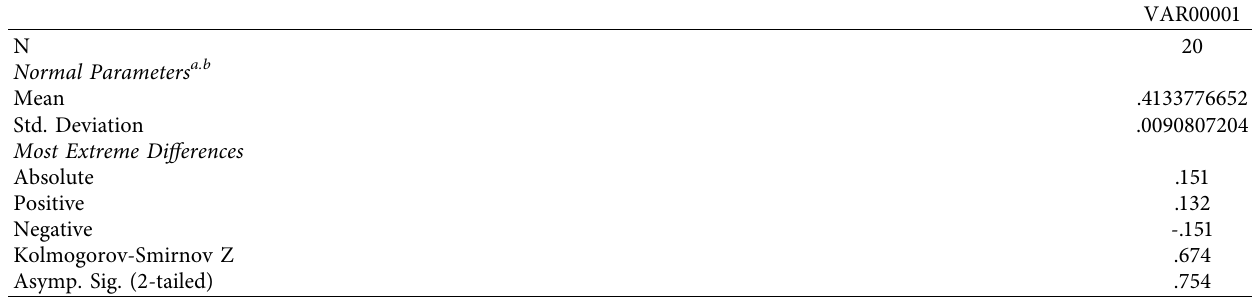
Table 6: The Kolmogorov–Smirnov test for the Collins data sample